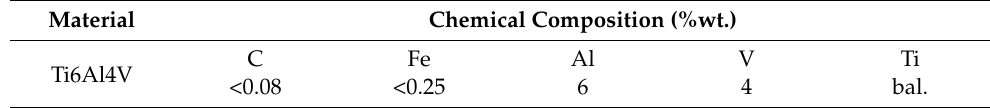
Table 1. Nominal chemical composition of Ti6Al4V grade alloy.